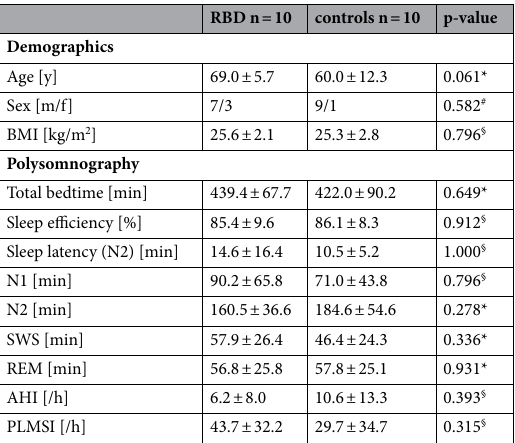
Table 1. Demographics and polysomnography data of 10 + 10 subjects for comparing human scorings. BMI body mass index, N1/2 non-rapid eye movement sleep stage 1/2, SWS slow wave sleep, REM rapid